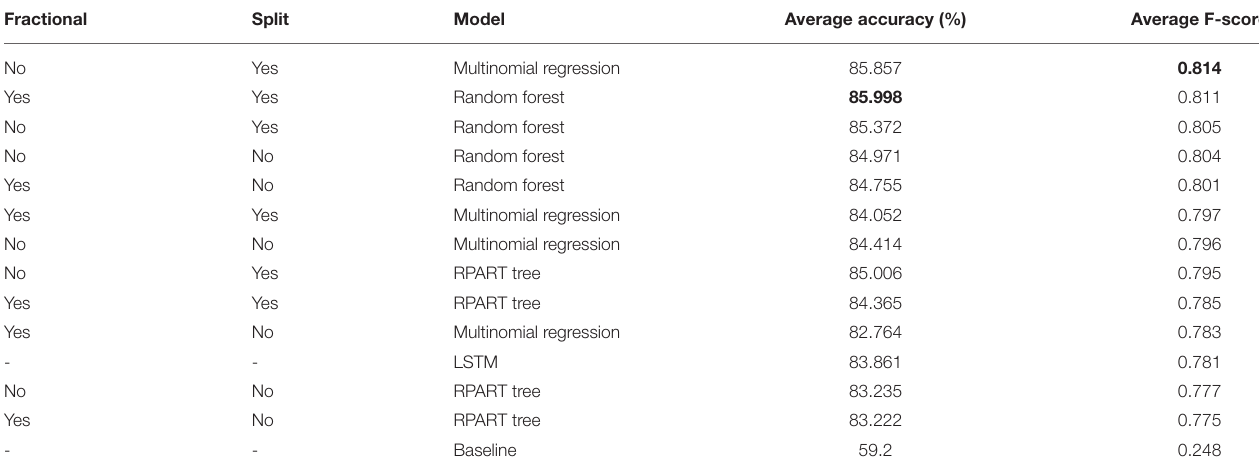
TABLE 3 | Accuracy and F-score for each combination of feature format and statistical model, as presented in section 3.4.